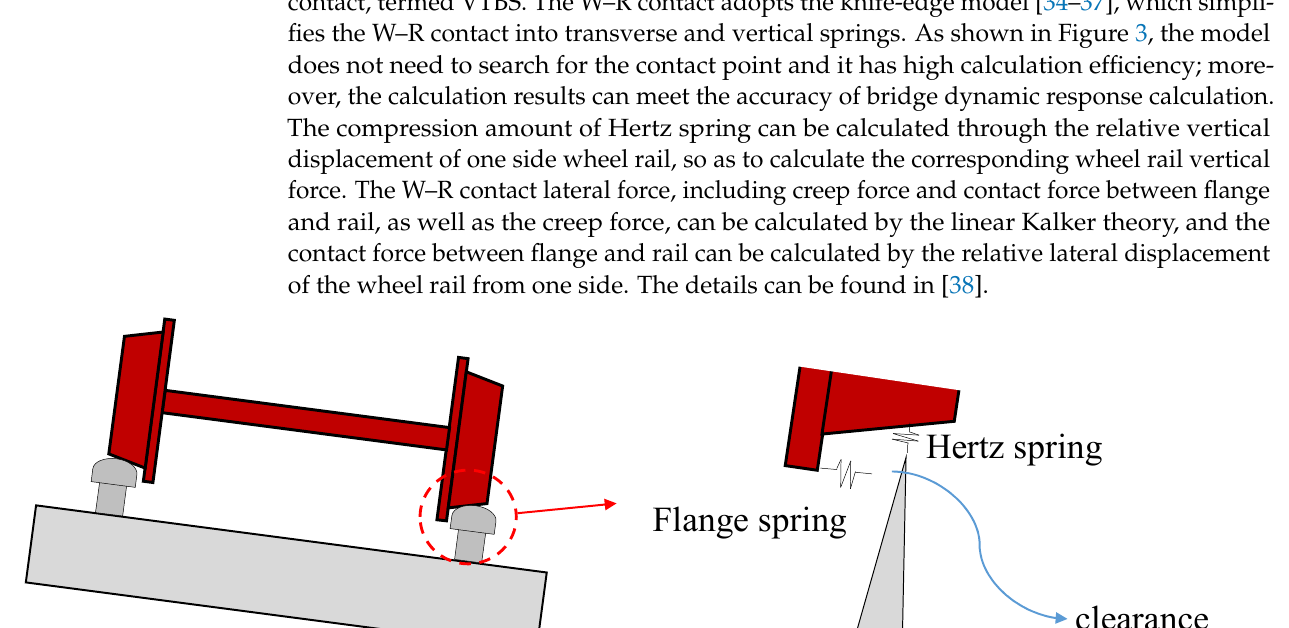
model does not need to search for the contact point and it has high calculation efficiency; moreover, the calculation results can meet the accuracy of bridge dynamic response cal- culation. The compression amount of Hertz spring can be calculated through the relative vertical displacement of one side wheel rail, so as to calculate the corresponding wheel rail vertical force. The W–R contact lateral force, including creep force and contact force between flange and rail, as well as the creep force, can be calculated by the linear Kalker theory, and the contact force between flange and rail can be calculated by the relative Figure 3. Wheel–rail contact model. Figure 3. Wheel–rail contact lateral displacement of the wheel rail from one side. The details can be found in [38].